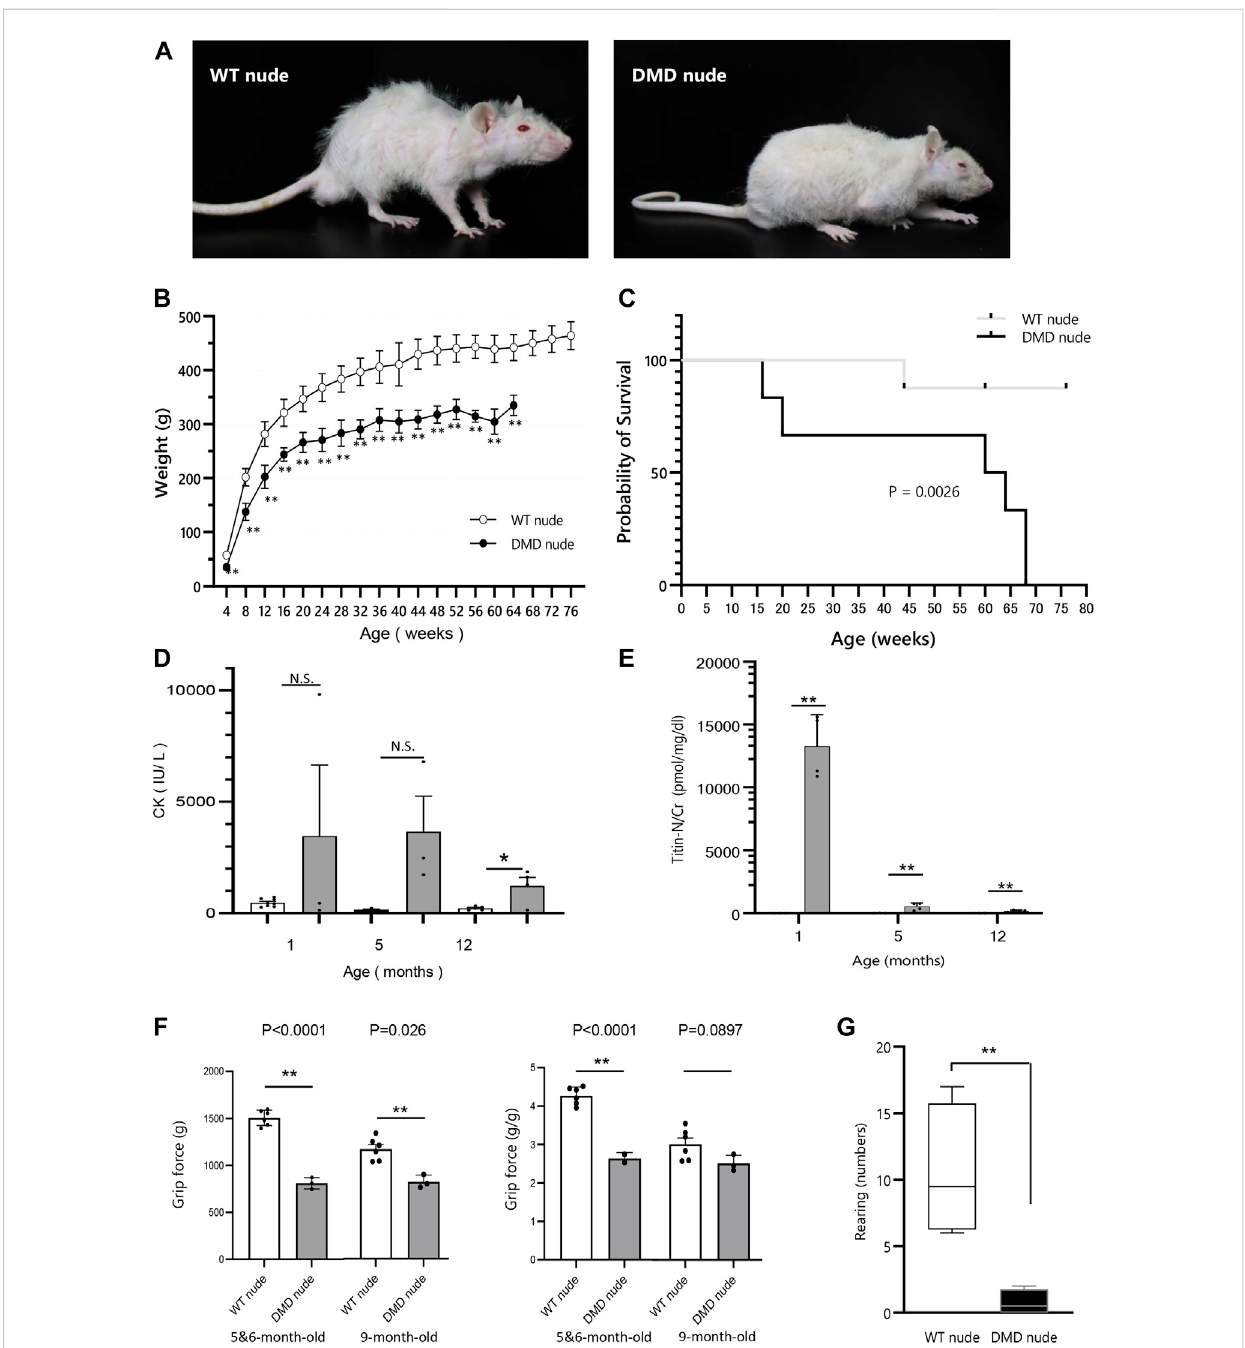
FIGURE 1 Generation of immunode fi cient Duchenne muscular dystrophy (DMD) rat model. (A) Representative images of 12-month-old wild type (WT) and DMD nude rats. (B) Body weight comparison of WT and DMD nude rats. (WT nude rat: n = 8, DMD nude rat: n = 7). (C) Kaplan-Meier curves comparing survivalratesofWTandDMDnuderats.Mantel-Coxtest, p =0.0026.(WTnuderat: n =8,DMDnuderat: n =7). (D) Theserumcreatinekinase(CK)activity inWT andDMD nude rats(WT nuderats: n = 8,3, and5;DMD nude rat: n = 3,3, and3). (E) The urinarytitinconcentrations inWTand DMD nude rats (WT nude rats: n = 3 for all groups; DMD nude rat: n = 4 for all groups). (F) Quanti fi cation of maximum muscle strength by grip test. The study was conducted on 5 to 6 and 9-month-old WT nude and DMD nude rats. (WT nude rat: n = 2, 2, DMD nude rat: n = 1, 1). (G) Motor behavior was examined using an open- fi eld test. WT and DMD nude rats at 12-month-old were individually placed in the cylinder for 3 min (WT nude rat: n = 4, DMD nude rat: n = 4). * p < 0.05, ** p <